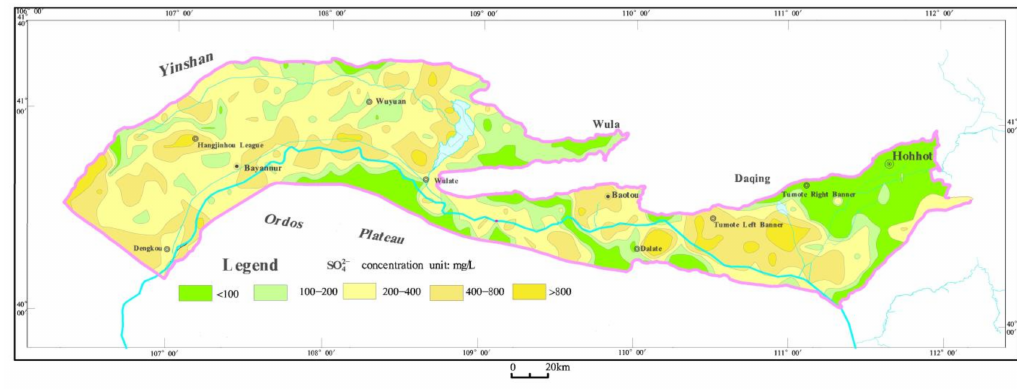
Figure 6. Zoning map of SO 42 − concentration in Hetao Basin.